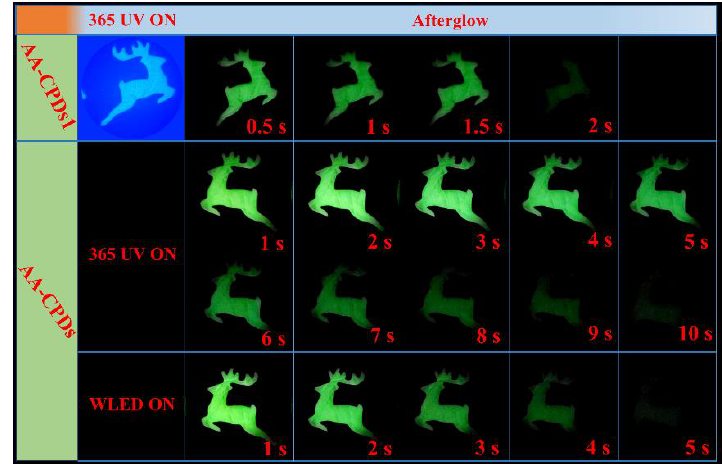
Figure 8. Image of AA-CPDs and AA-CPDs1 powders under UV 365 nm on and off with